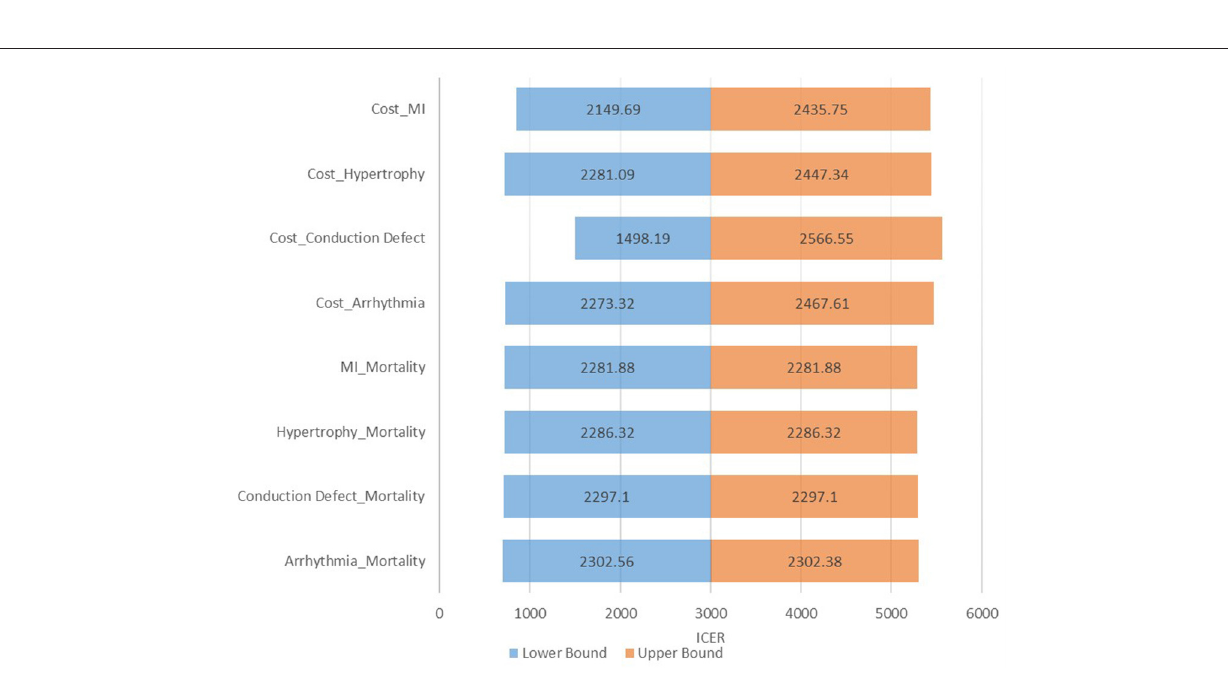
as high-risk, active screening through ECG can be an effective strategy (5, 6, 17–27). A standardized risk-stratification tool